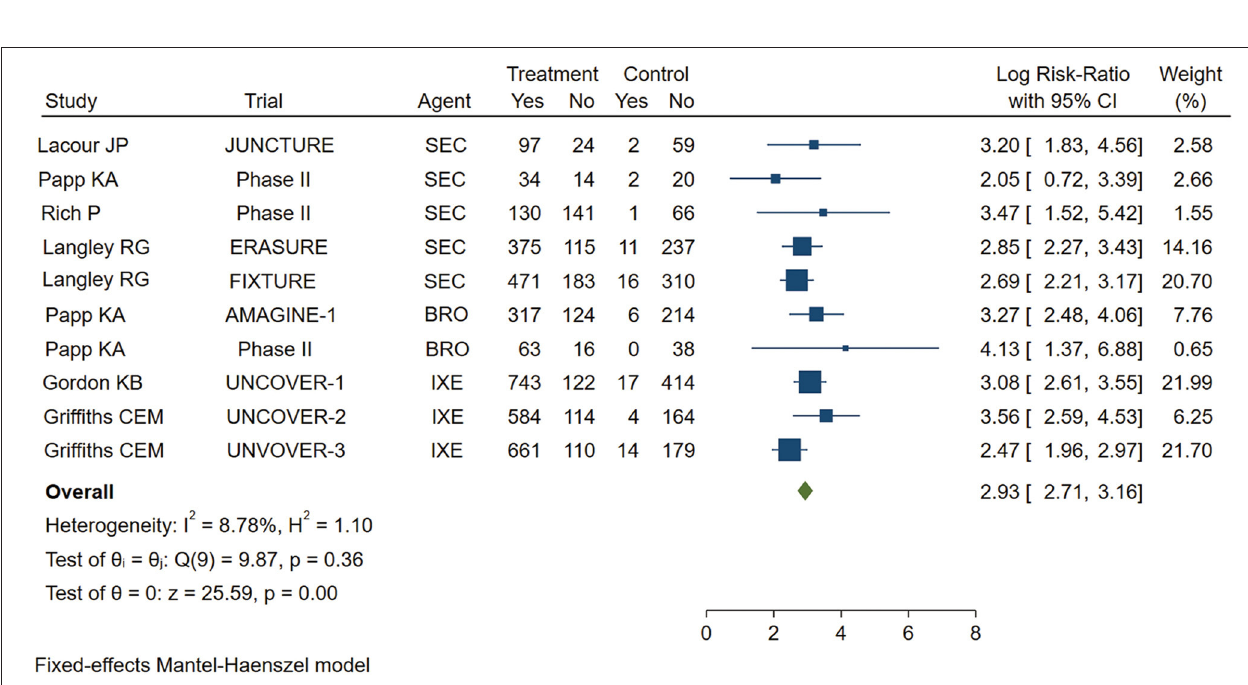
FIGURE 2 | Meta-analysis of Asian patients treated with IL-17 inhibitors or placebo for the PASI 75 response at week 12. RR, risk ratio; SEC, secukinumab; BRO, brodalumab; IXE, ixekinumab; Q4W, every 4 weeks; Q2W, every 2 weeks; IL-17, interleukin-17; PASI, Psoriasis Area and Severity Index 75.